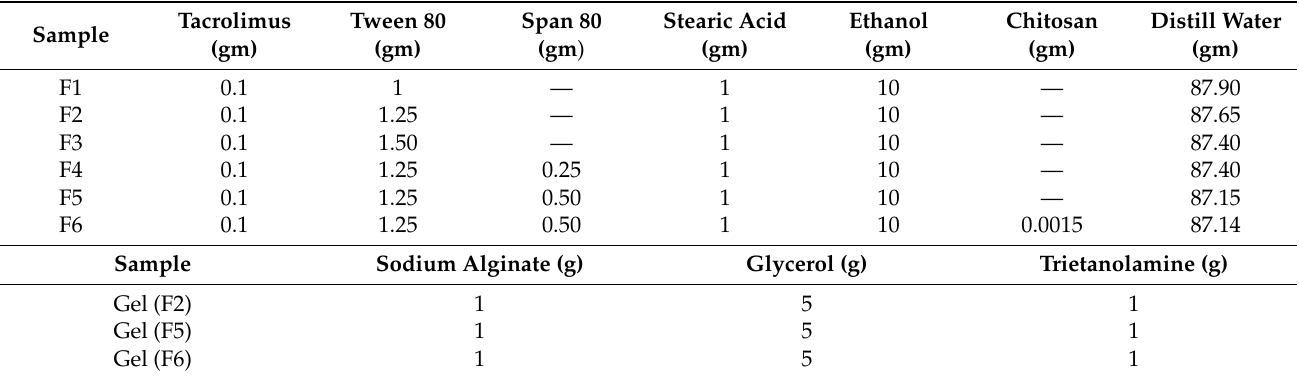
Table 1. ( A ): Composition of drug-loaded SLNs formulations; ( B ): Composition of optimized SLN gel